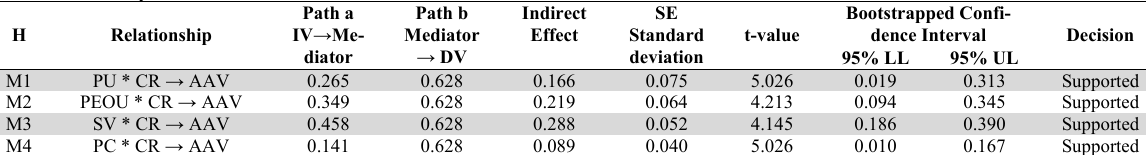
Moderator Analysis Result